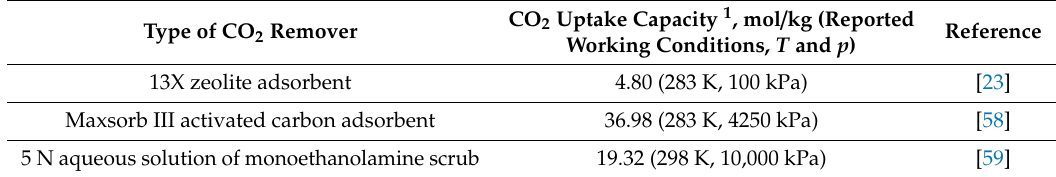
Table 2. CO 2 removal performances of the state-of-the-art currently used